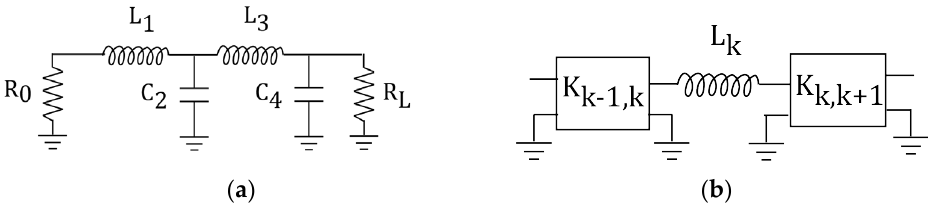
Figure 2. ( a ) Lowpass filter. ( b ) Modified prototype using impedance inverters.